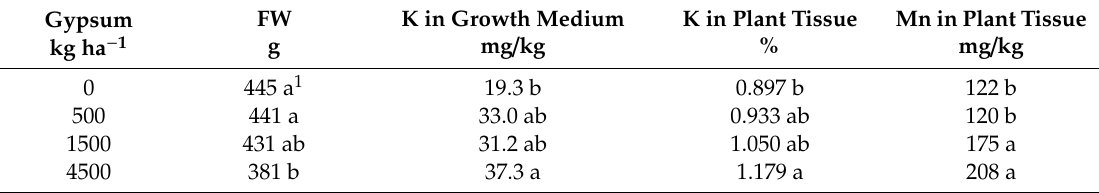
Table 6. Mean Fresh weight (FW, g), growth medium-available potassium (K), and nutrient content of plant tissue from distillation waste [K and manganese (Mn)] obtained from the four levels of Gypsum application in the lemongrass